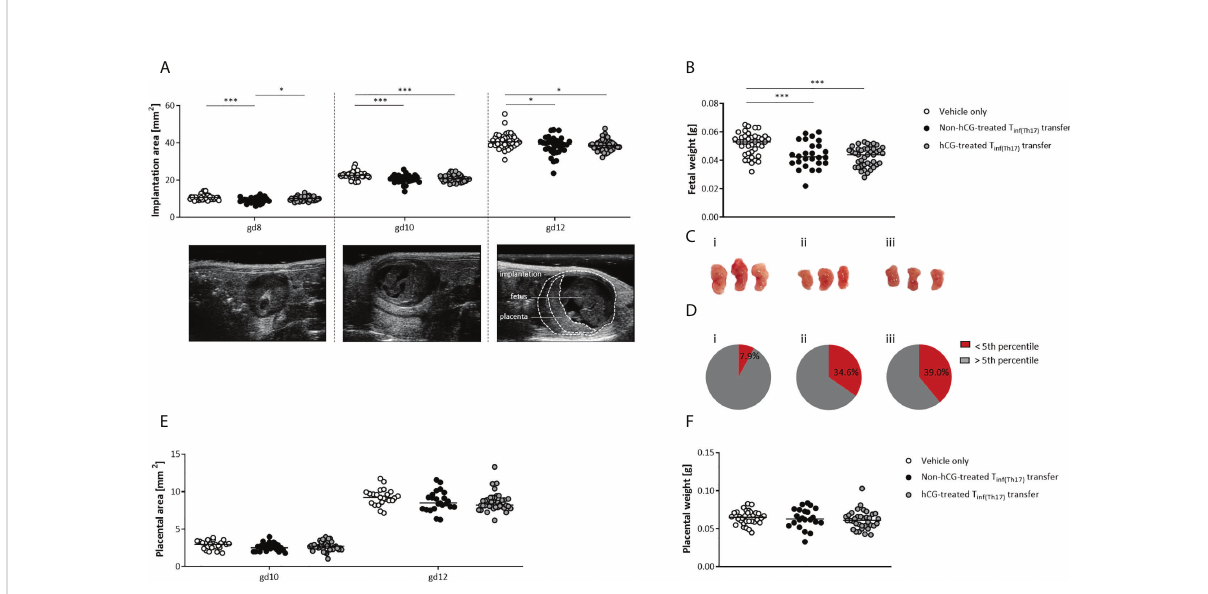
FIGURE 7 Adoptive transfer of T inf(Th17) cells, with or without hCG treatment during Th17 differentiation, impaired fetal growth. Naïve CD4 + T cells were isolated by magnetic-activated cell sorting (MACS), polarized into Th17 cells under Th17-differentiating conditions for 3 days in vitro , in the presence or absence 500 mIU/ml rhCG, and then injected into pregnant CBA/J females during the fi rst 2 days of gestation. (A) Implantation areas on gd 8, 10 and 12, determined by high-frequency ultrasonography. Examples of ultrasonography of individual implantations on each day are also shown. (B) Fetal weights on gd 12. (C) Examples of fetuses from vehicle-only ( n = 7) (i), non-hCG-treated ( n = 6) (ii) and hCG-treated ( n = 8) (iii) groups on gd 12. (D) Percentages of fetuses with weights below the fi fth percentile (intrauterine growth restriction) or above the fi fth percentile on gd 12. (E) Placental areas on gd 10 and 12 measured by ultrasonography. (F) Placental weights on gd 12. Data are presented as medians showing individual values for each implantation/fetus/placenta. For comparisons between experimental groups, a mixed linear model using the fi nal test principle was applied. Following, medians are provided for signi fi cant differences between groups for Implantation areas: 10.64 vs 8.942 (gd8), 22.61 vs 21.00 (gd10), 40.67 vs 39.18 (gd12) (vehicle only vs non-hCG-treated Th17 cells), 22.61 vs 20.71 (gd10), 40.67 vs 38.64 (gd12), (vehicle only vs hCG-treated Th17 cells), 8.942 vs 10.10 (gd8) (non-hCG-treated Th17 vs hCG-treated Th17 cells); for Fetal weights: 0.053 vs 0.0425 (vehicle only vs non-hCG-treated Th17 cells), 0.053 vs 0.044 (vehicle only vs hCG-treated Th17 cells). * indicates p < 0.05; *** indicates p < 0.001. gd, gestational